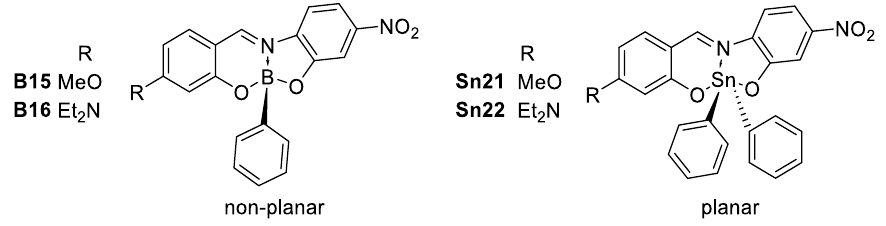
Figure 40. Diorganotin and corresponding diorganoboron as representative members of these families of complexes.